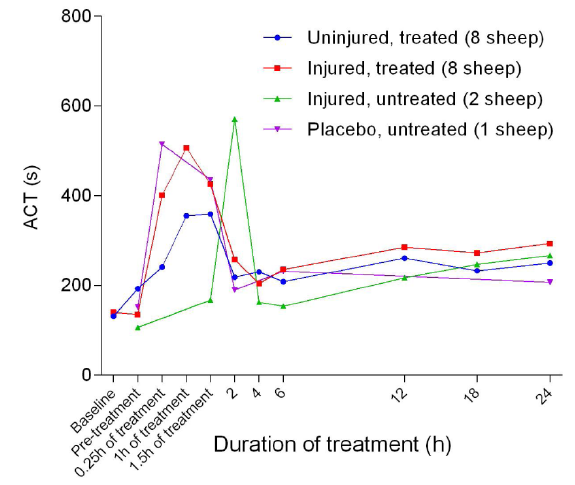
Figure 45. Activated clotting time (ACT) (Mean ± SD, error bars not shown) in smoke and non-smoke injured sheep that received extracorporeal life support as compared to that in untreated